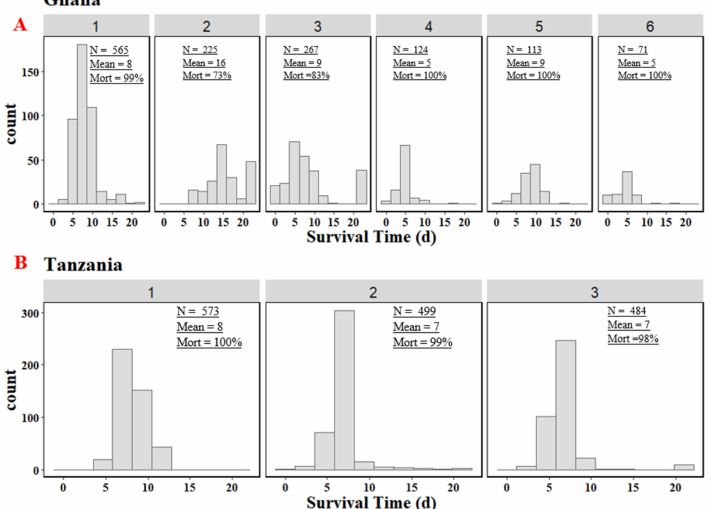
Figure 1. Survival time in days for 6 replicates for Ghana ( A ) and 3 replicates for Tanzania ( B ). N = number of birds in the replicate; Mean = average survival from exposure to 21 days within the replicate; Mort = % of birds that survived to the end of the experiment (21 days after